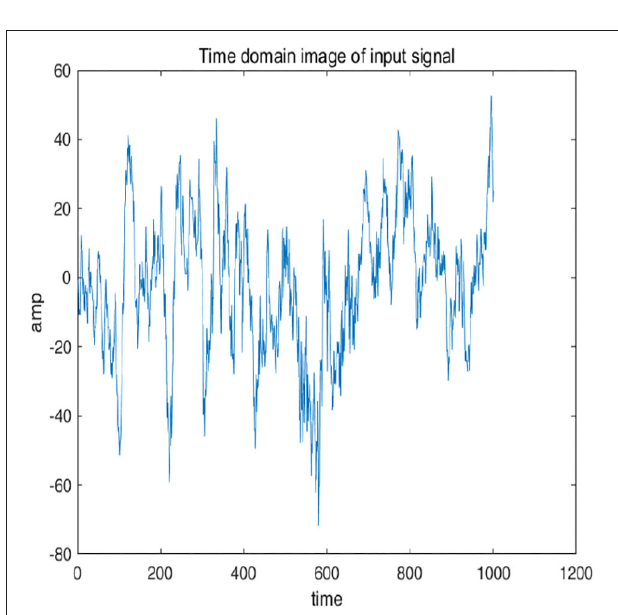
FIGURE 8 | Time-domain image of signal in pre-ictal is shown in